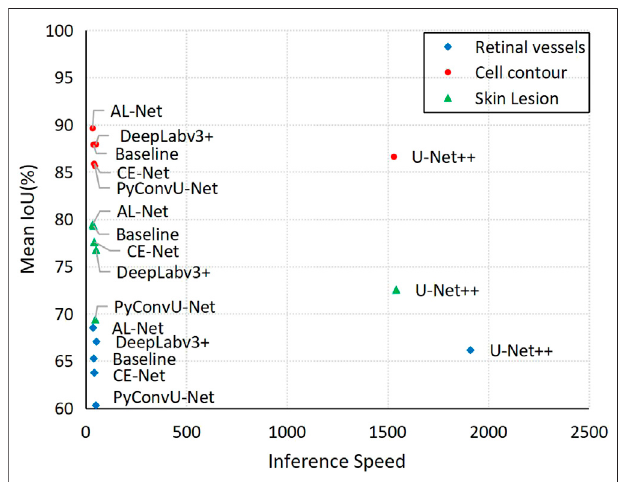
FIGURE 8 | Speed-accuracy trade-off comparison of six models on three test